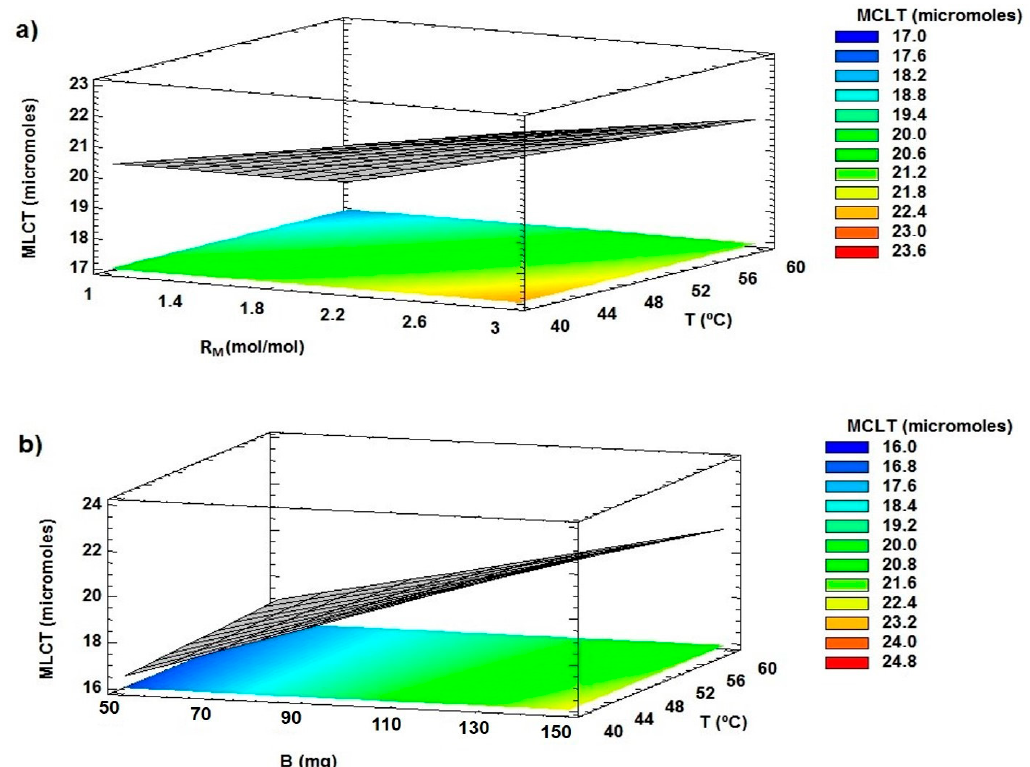
Figure 9. Generation of 1,3-dicaproyl-2-palmitoyl glycerol + 1,2-dicaproyl-3-palmitoyl glycerol (both classified as MLCT) by the esterification of dicaprin with palmitic acid catalyzed by BCL / chitosan. ( a ) Variables: R M and reaction temperature for a biocatalyst dosage of 150 mg, ( b ) Variables: mass of biocatalyst and reaction temperature carrying out the reaction with the highest proportion of palmitic acid evaluated in this study.